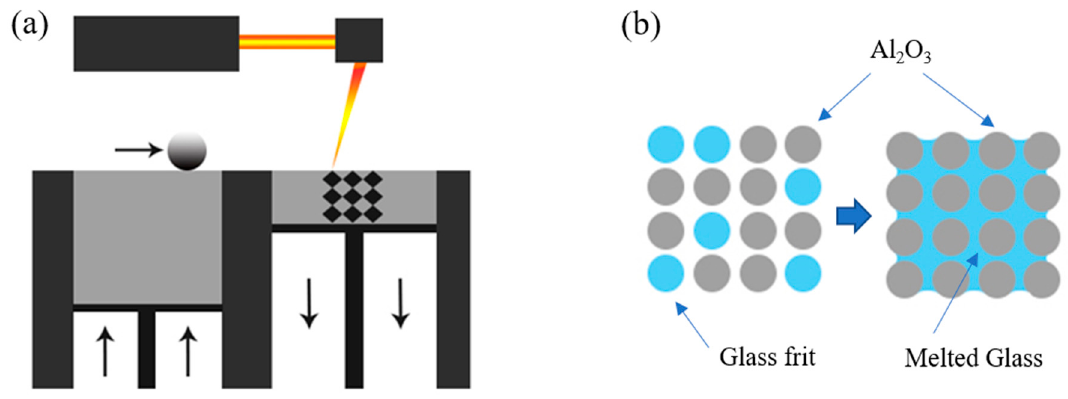
Figure 1. Mechanism of density improvement of glass / Al 2 O 3 composite: ( a ) 3D printing powder bed fusion (PBF) process; and ( b ) schematic of glass frit / Al 2 O 3